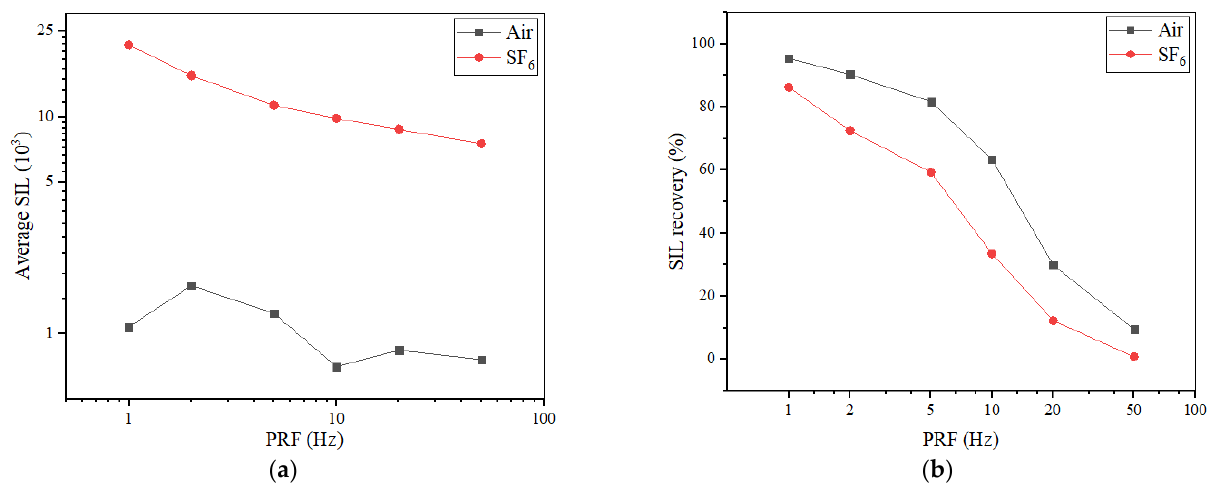
Figure 6. ( a ) SIL and ( b ) SIL recovery percent vary with